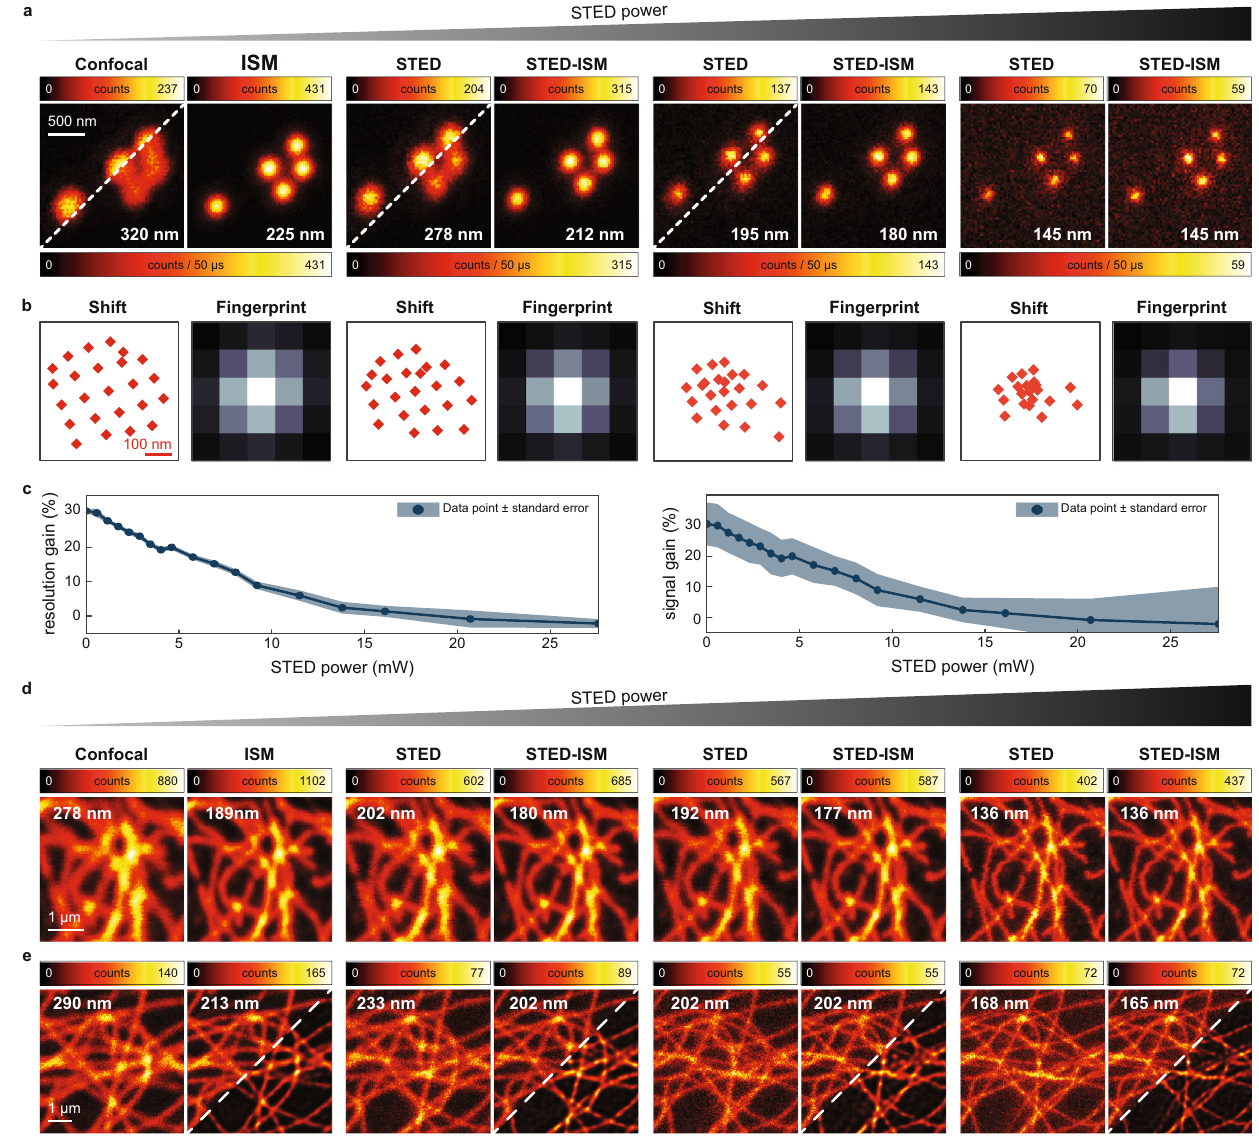
Fig.3|STED-ISMimaging. In( a ),wecomparerawimagesof fl uorescentbeadswith the corresponding ISM reconstructions. In ( b ), we show the shift vectors and fi n- gerprint calculated from animage ofthe beads. In ( c ),weshow the resolutiongain (left) and the signal gain (right) of STED-ISM with respect of STED, for increasing STEDpowers.Wemeasuretheresolutionandthesignal,respectively,astheFWHM andthepeakvalueof thesuccessful fi tofthe fl uorescentbead toaGaussiancurve. The graphs report the average values of multiple beads with the corresponding